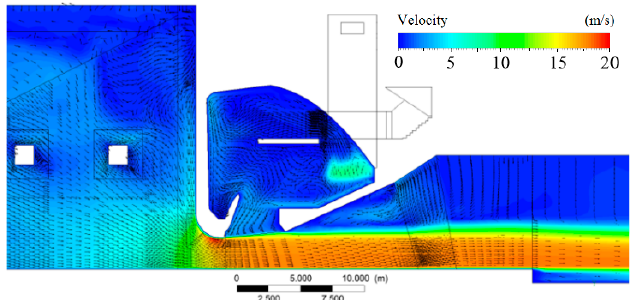
Figure 8. Case 1, water-air flow field colored by velocity magnitude, along the left outlet’s centerplane.